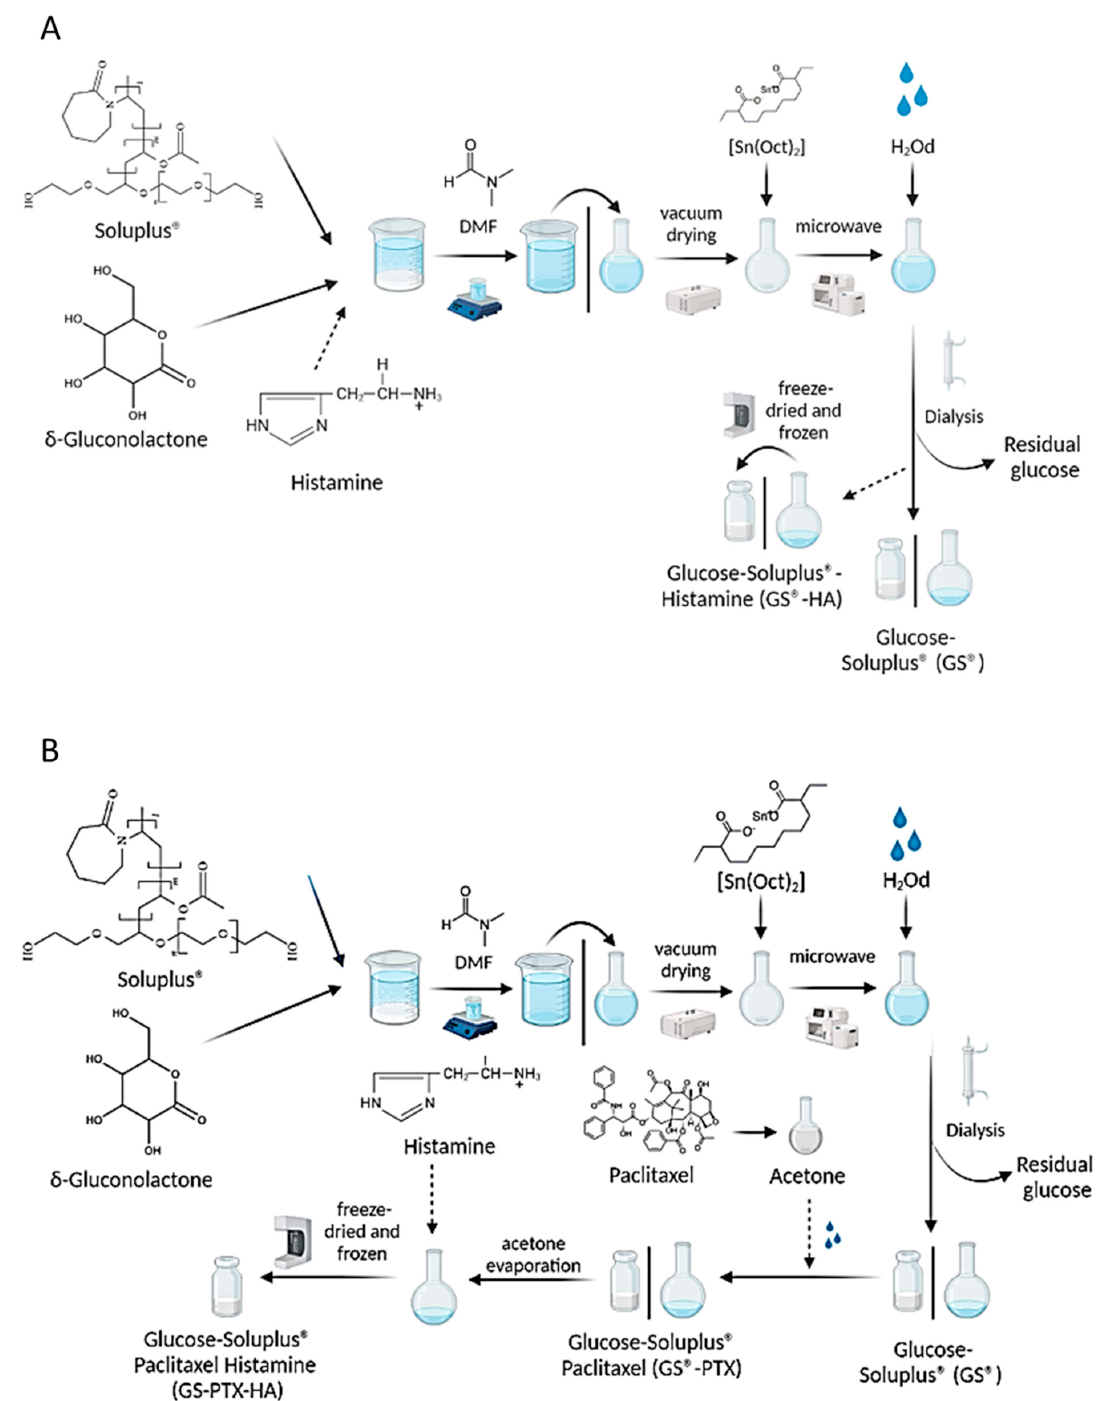
Figure 9. Schematic representation of Glucose-Soluplus ® micelles synthesis. ( A ) The arrows indicate the direction of the process, from the initial mixture of Soluplus ® and δ -gluconolactone to the final obtaining of freeze-dried glycosylated micelles (GS 5% w/v ). The dotted arrows represent the possible addition of histamine in the synthesis to obtain histamine-glycosylated micelles (GS-HA 5 mg/mL). ( B ) The dotted arrows represent the possible addition of paclitaxel with or without further addition of histamine in the synthesis to obtain GS-PTX (4 mg/mL) and GS-PTX-HA (4 mg/mL: 5 mg/mL) micelles. References: DMF (dimethylformamide); Sn(oct)2 (tin octoate); H 2 Od (deionized water). Figure created with BioRender.com (accessed on 29 November 2022).